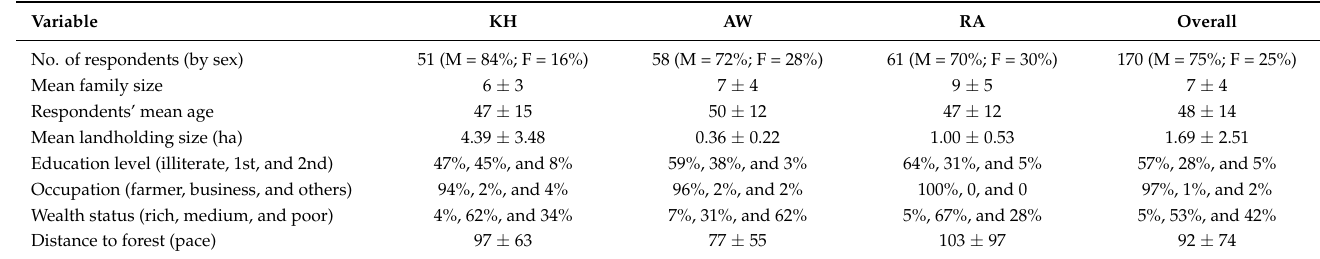
Table 2. Household (HH) characteristics of the three districts of Tigray Region,